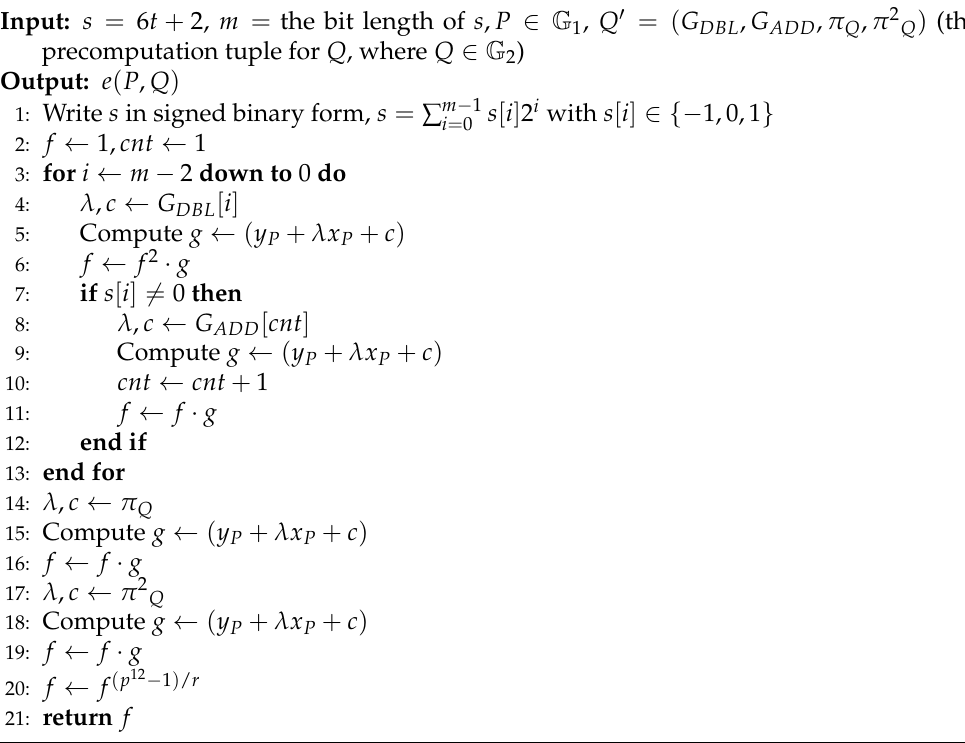
Algorithm 4 Fixed-Q